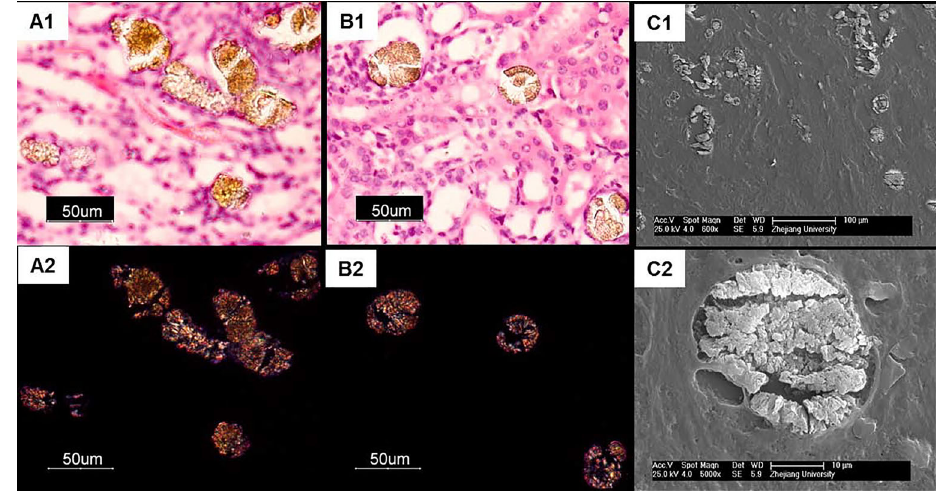
Figure 6. The crystal complex in the renal tubular lumina of the mice with dietary co-exposure to melamine and CA (10:1) examined by re fl ection-mode-cross-polarized microscope ( A1 , A2 , B1 , B2, scale bars: 50 m m) and fi eld-emission scanning electron microscope ( C1 , C2, scale bars: 100 and 10 m m,